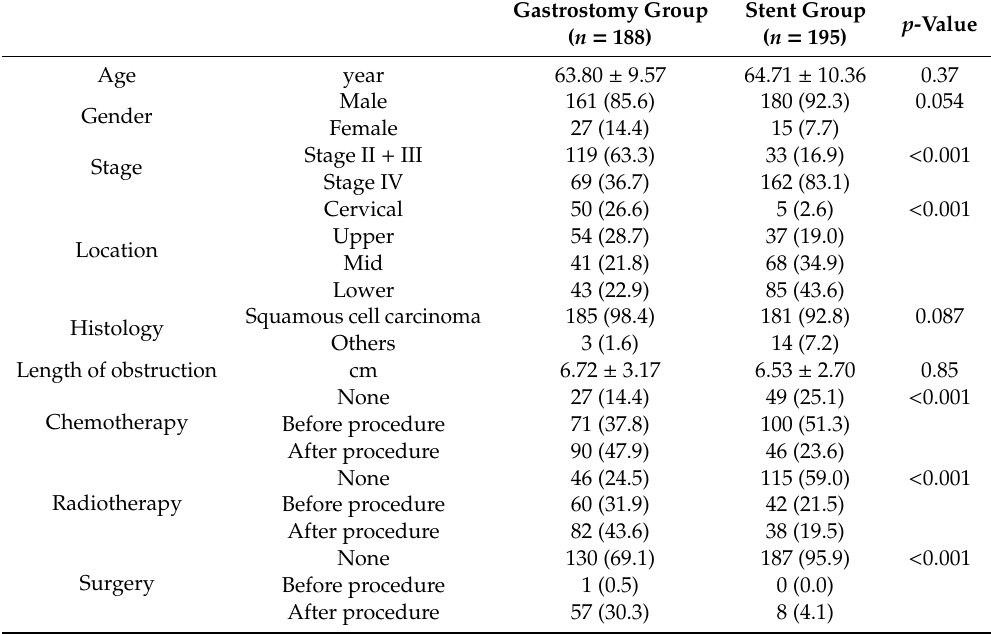
Table 1. Comparison of baseline characteristics between patients with malignant esophageal obstruction undergoing gastrostomy and stent insertion, before propensity score matching ( n =